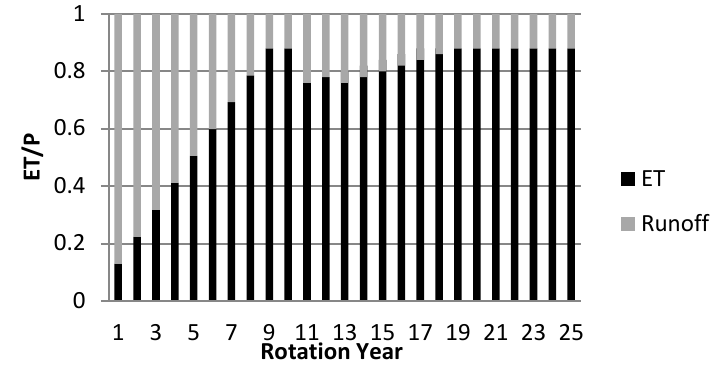
Fig. 1 Annual ET as a percent of rainfall over a forest